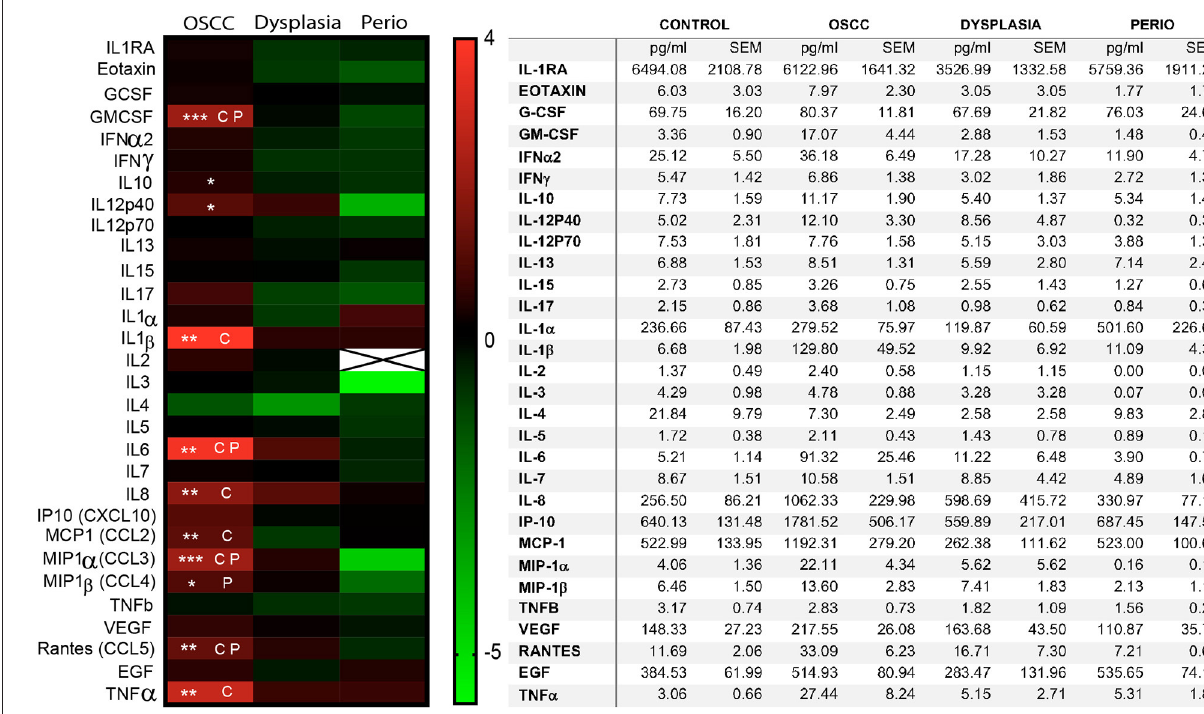
FIGURE 2 | Expression of inflammatory mediators in saliva. The inflammatory mediators were quantified using a 30-plex Luminex panel using non-fixed, filtered saliva. The left panel shows a heatmap of the mean concentration of the individual cytokines compared to control group, using a Log2 scale. The table on the right shows the average concentration of inflammatory mediators in each sample and the standard error of the mean (SEM). (CP) Significant statistical differences between OSCC samples and periodontitis as well as controls. (C) Significant statistical differences between OSCC samples and controls. (P) Significant statistical differences between OSCC and periodontitis samples ( n = 69, * p < 0.05, ** p < 0.01, *** p < 0.001).